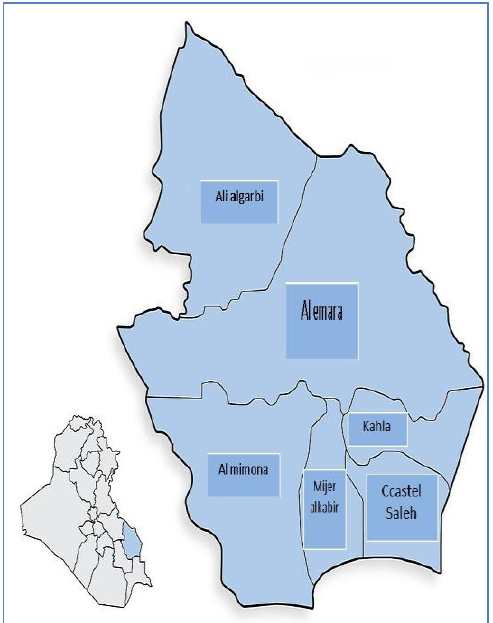
Fig. 1: Map of Missan